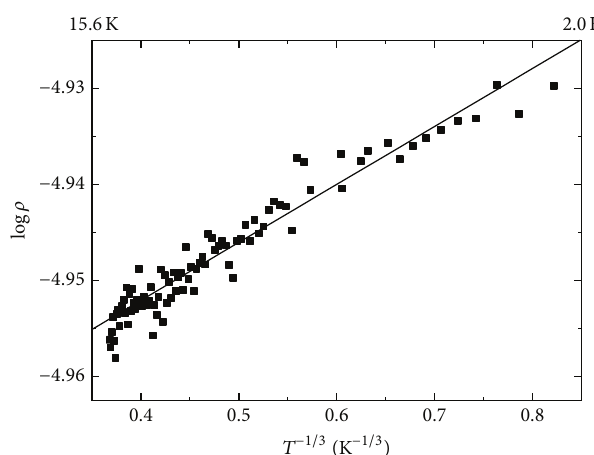
Figure 6: 𝑇 −1/3 dependence of log 𝜌 for sulfur-deintercalated Nd 3.5 Sm 0.5 Ni 3 O 8